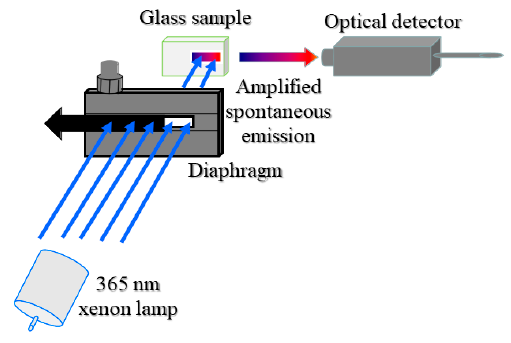
Figure 1. Setup of characterization system for optical gain.